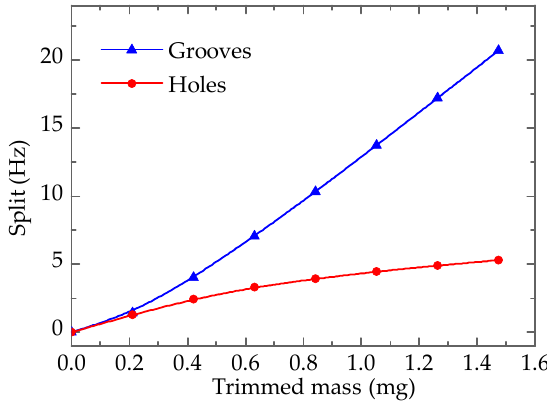
Figure 9. Frequency split of different trimming methods.